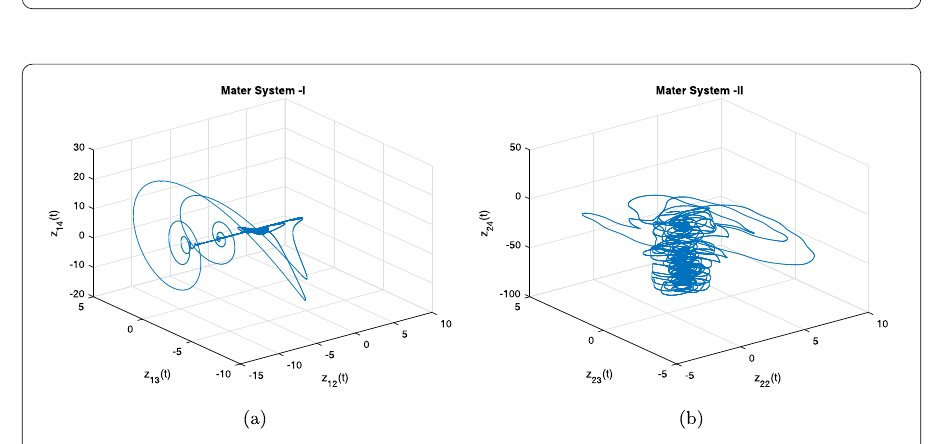
Figure 7 Chaotic attractor of the master systems